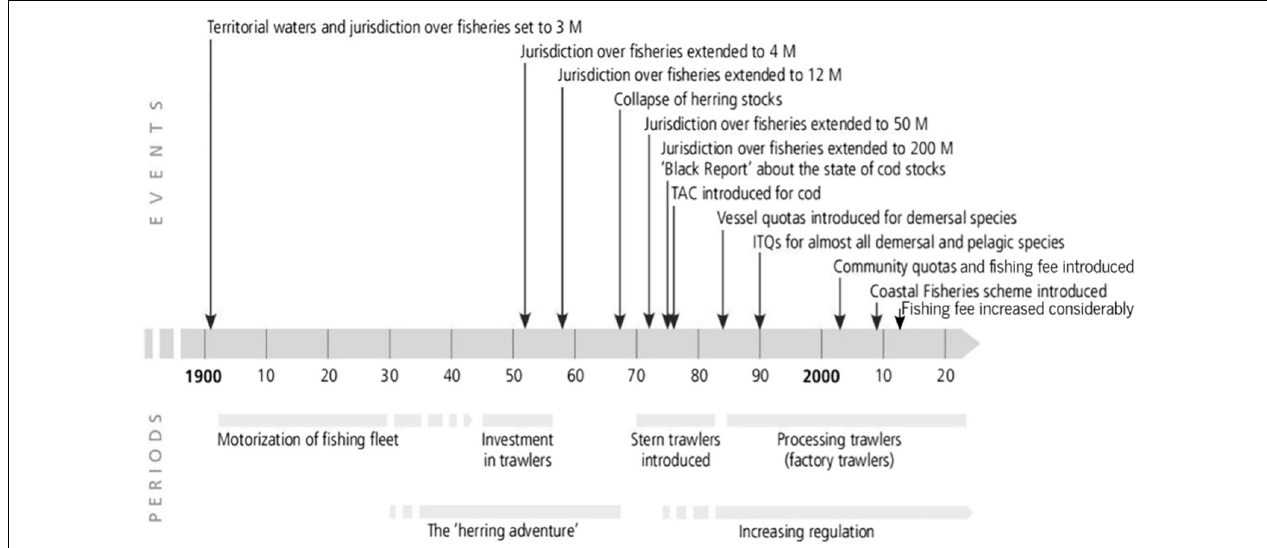
FIGURE 5 | Major historic events in the Icelandic fisheries system (after Kokorsch and Benediktsson, 2018, with additions (“Fishing fee increase”) by the authors, based on Gunnlaugsson, 2020).